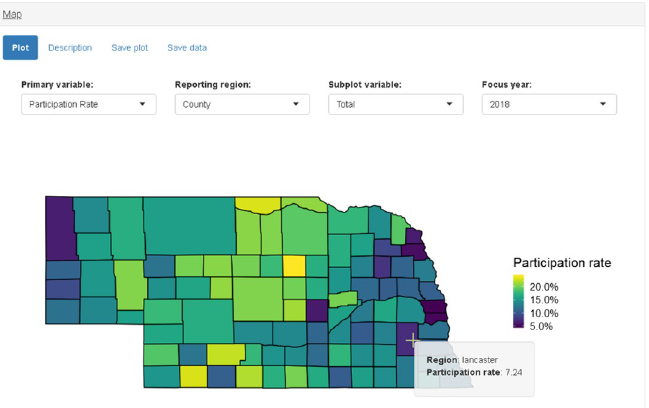
Fig 6. Screenshot of map panel when “participation rate” is selected as primary variable and “county” is selected as reporting region.